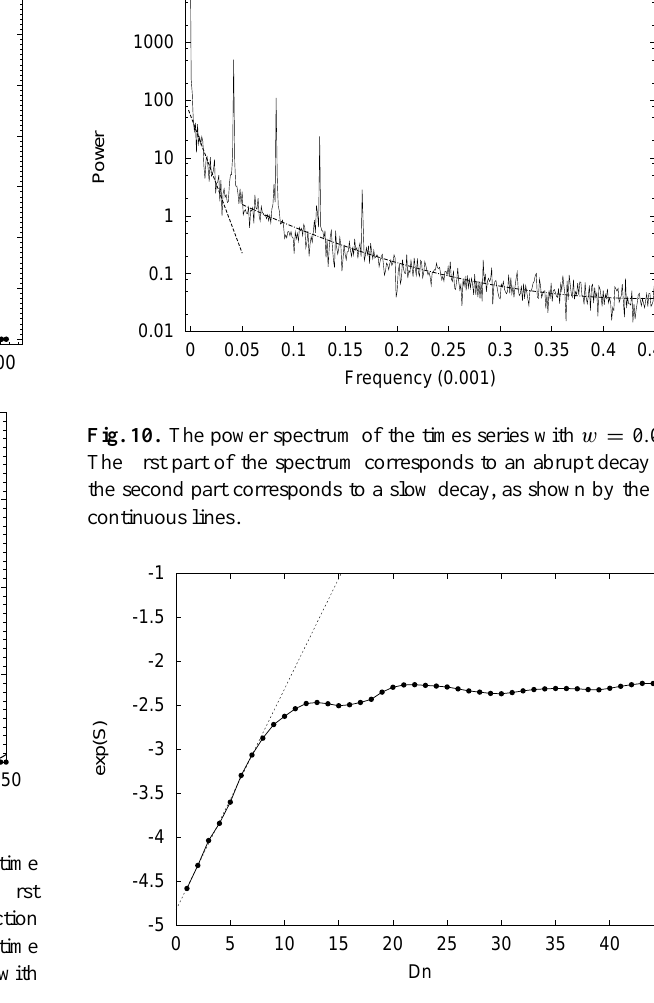
Fig. 11. The curve of e S(1n) for the embedding dimension m = 12 . The slope of the dashed line is 0 . 25 ± 0 . 006 and it is the maximum Lyapunov exponent of the time series of H